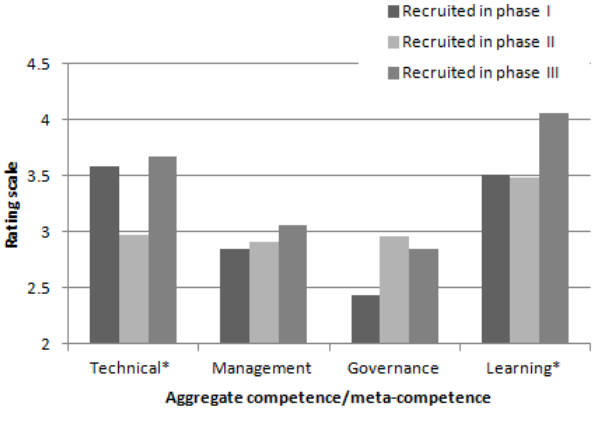
Fig. 5. Aggregate competences and meta-competence perceived to be acquired during LPE or IPE in phase I (1970–1987), II (1987– 1998) and III (1998–present); rating scale from 1 to 5, where 1=not at all, 3=to some extent, and